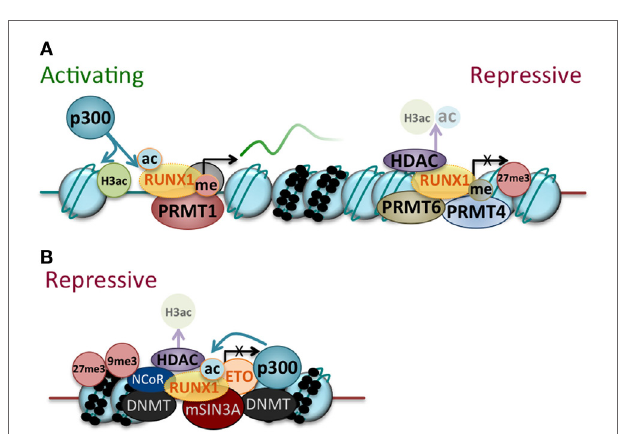
FiGURe 2 | RUnX1 and RUnX1–eTO regulate gene expression by recruiting transcriptional cofactors and epigenetic modifiers . (A) RUNX1 can act as a transcriptional activator or repressor dependent on the balance of coactivators/corepressors associated with it at a particular time. RUNX1 can recruit coactivators [for example, p300 histone acetyltransferase (p300) and protein arginine methyltransferase (PRMT1)] and epigenetic modifiers, which enhance RUNX1 activity through post-translational modification (shown as acetylation (ac) and methylation (me) of the RUNX1 protein) and impart activating modifications to chromatin [for example, histone 3 acetylation of lysine 9 and 14 (H3ac)]. RUNX1 can also recruit corepressors and epigenetic modifiers [for example, PRMT6 and PRMT4 as well as histone deacetylases (HDAC)], which inhibit RUNX1 activity through post-translational modification (removal of acetylation marks from RUNX1 and chromatin) and establish repressive chromatin modifications (for example, histone 3 lysine 27 trimethylation, 27me3). Various continuums of the two extremes that are shown no doubt exist. (B) RUNX1–ETO binds to